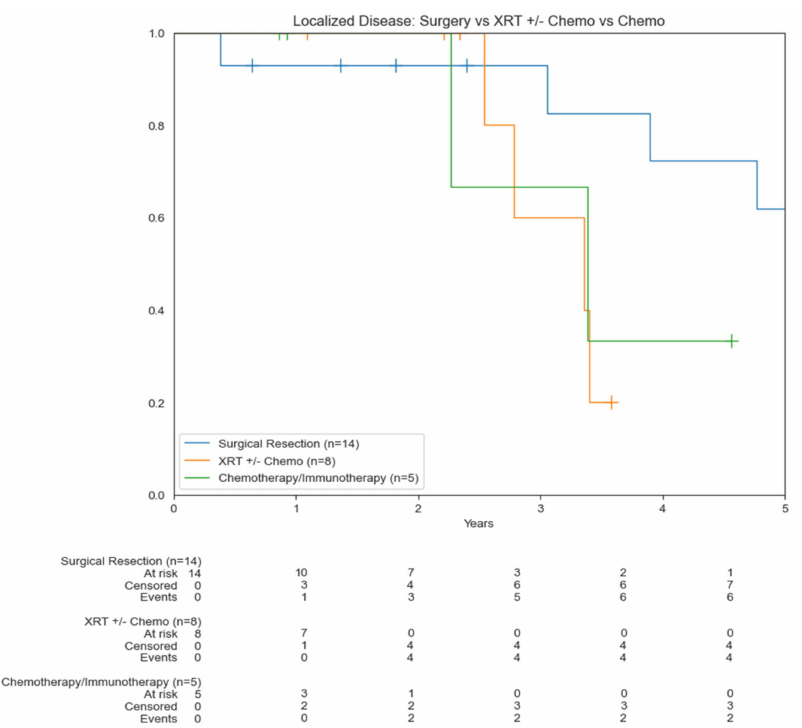
Figure 5. Kaplan–Meier curves comparing OS based on treatment modality in localized